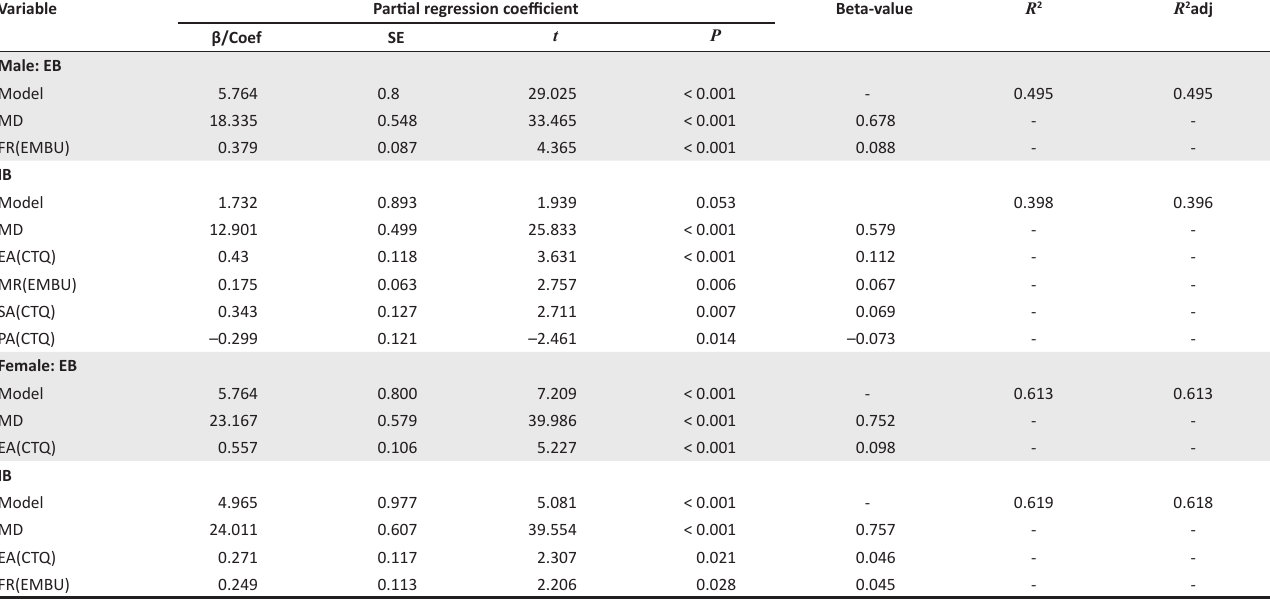
TABLE 4: Regression model for externalising and internalising behaviour (CBCL score). Variable